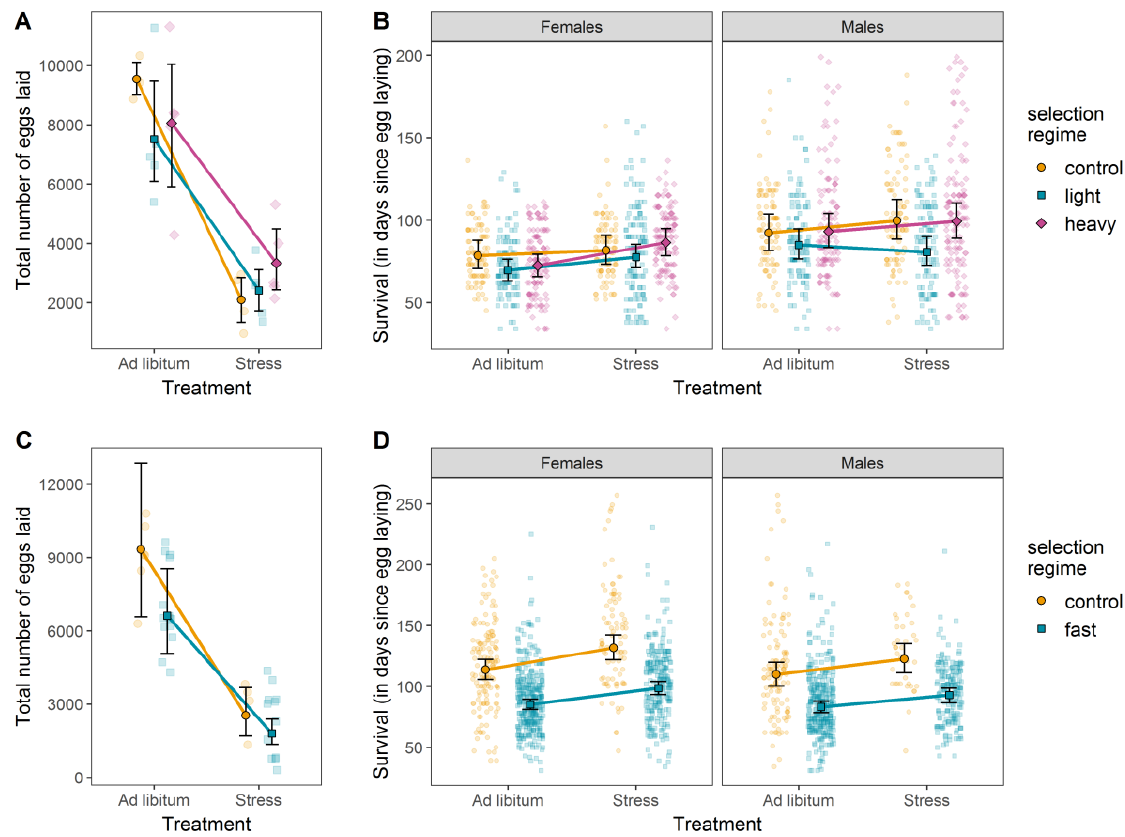
Figure 4: Adult phenotypic responses to selection on female body mass and age at first reproduction. (A) Fecundity of G9 females from experimental lines of the female body mass selection. (B) Female and male survival of G9 individuals of the female body mass selection. (C) Fecundity of G10 females from lines of the age at first reproduction selection. (B) Female and male survival of G10 individuals of the age at first reproduction selection. Color code is similar to Figure 1. Error bars represent standard errors between